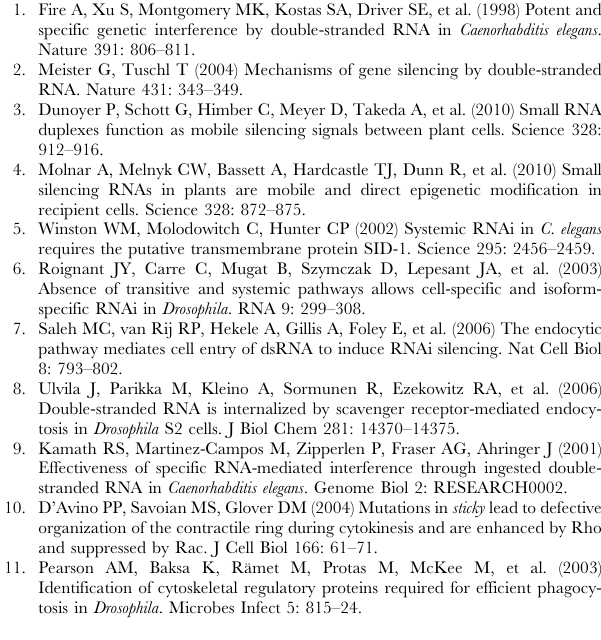
Figure S2 Cytochalasin D (CytoD) treatment of Drosophila S2 cells inhibits both dsRNA-mediated and E. coli mediated RNAi. Western blots showing amphiphysin and b -tubulin protein levels in S2 cultures treated with CytoD or ethanol (EtOH, control) prior to Amph knockdown by RNAi using varying amounts of either naked amph dsRNA or E. coli that expressed amph